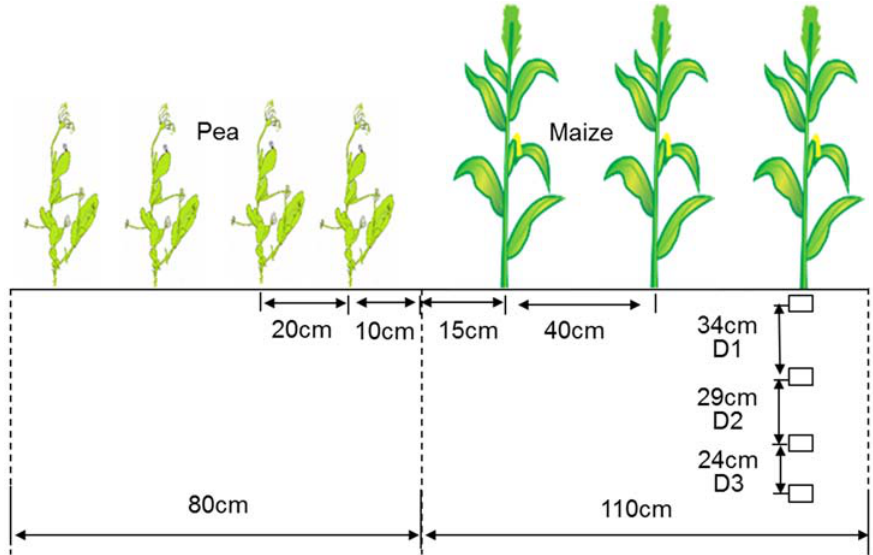
Figure 1. Spacing in maize/pea intercropping plots at the Wuwei Oasis Agriculture Experimental Station in the Hexi Corridor of northwestern China. Maize populations were 45,000 plants ha − 1 (D1), 52,500 plants ha − 1 (D2), and 60,000 plants ha − 1 (D3).